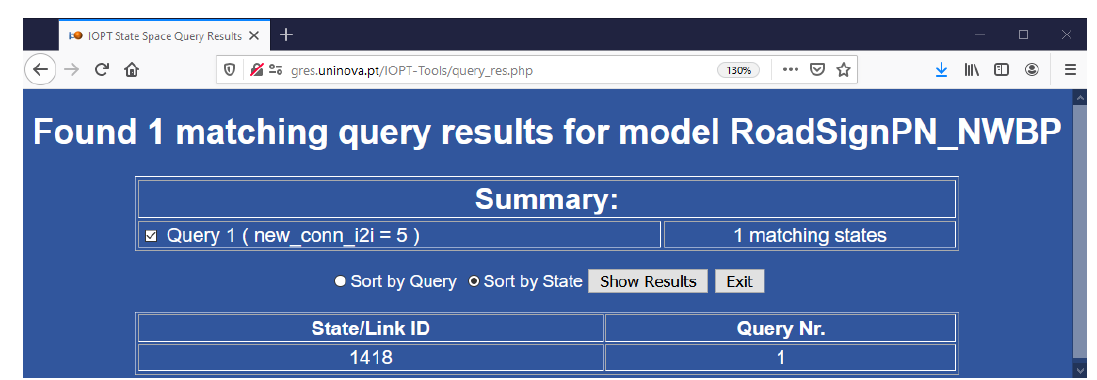
Figure 8. IOPT query edition tool with the queries performed to the controller model of the NWBP module.